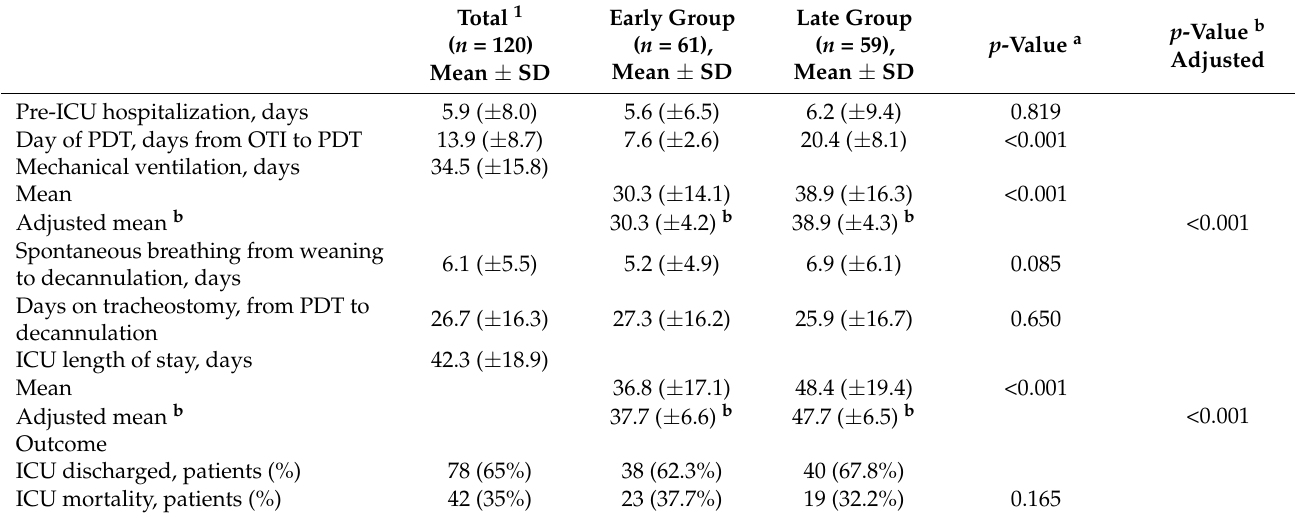
Table 3. The clinical characteristics during patient ICU